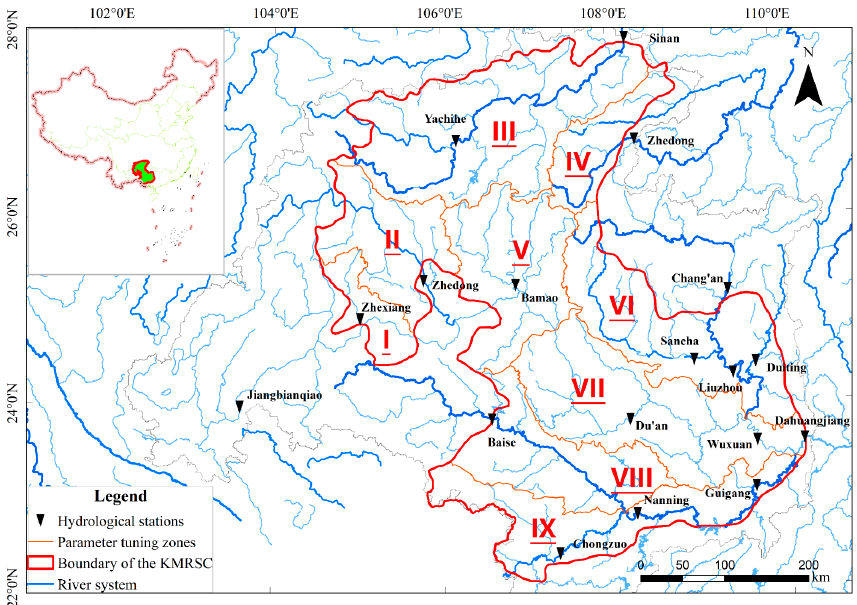
Figure 7. Parameter tuning zones in the karst mountain region of southwest China.